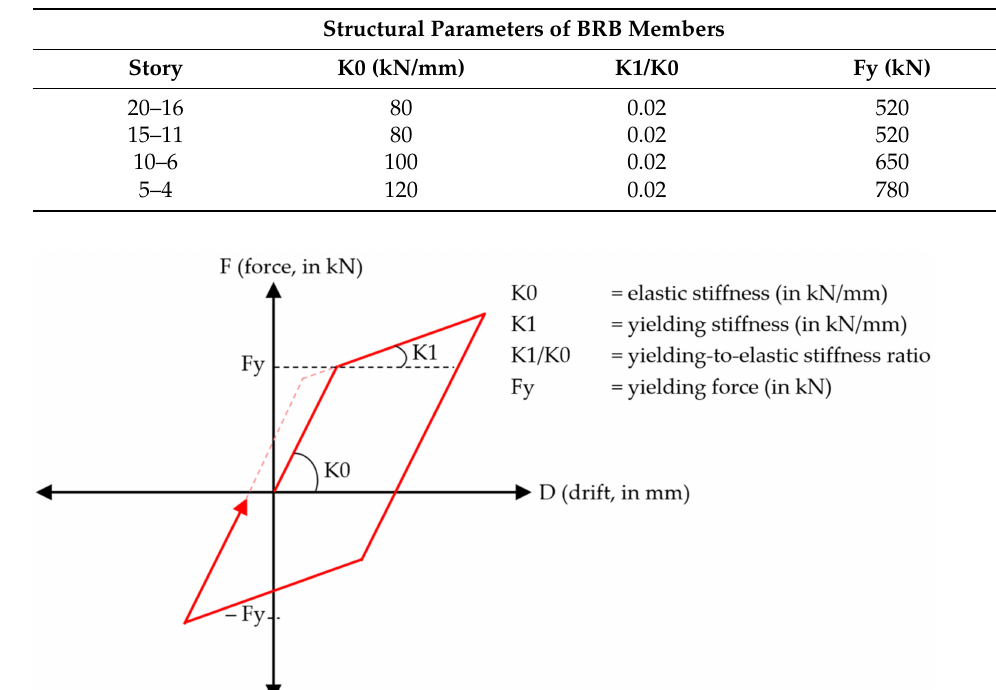
Table 6. Strength of BRB adopted in study 1.